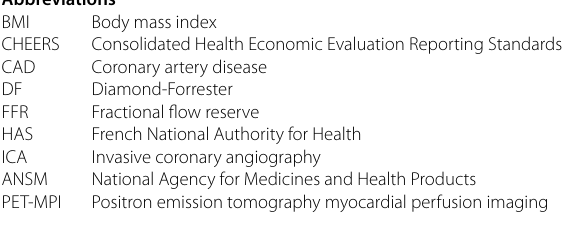
procedure. Table S4. Resources used in Tc‑SPECT‑MPI